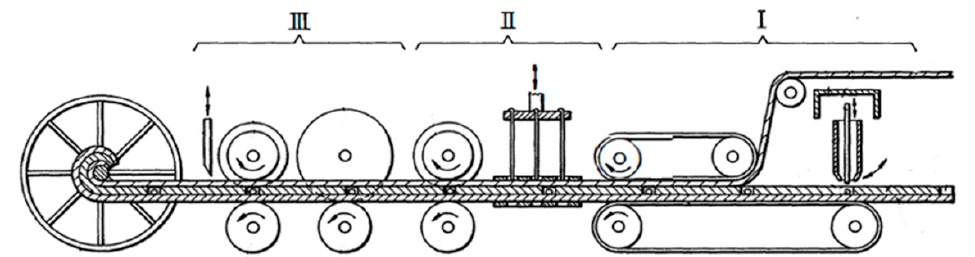
Figure 3. Machine for forming seed tape designed by Scholl [57]. Part Ⅰ is the drilling seed supply system; part Ⅱ is the rope reinforcement system and part Ⅲ is the seed rope compaction system.